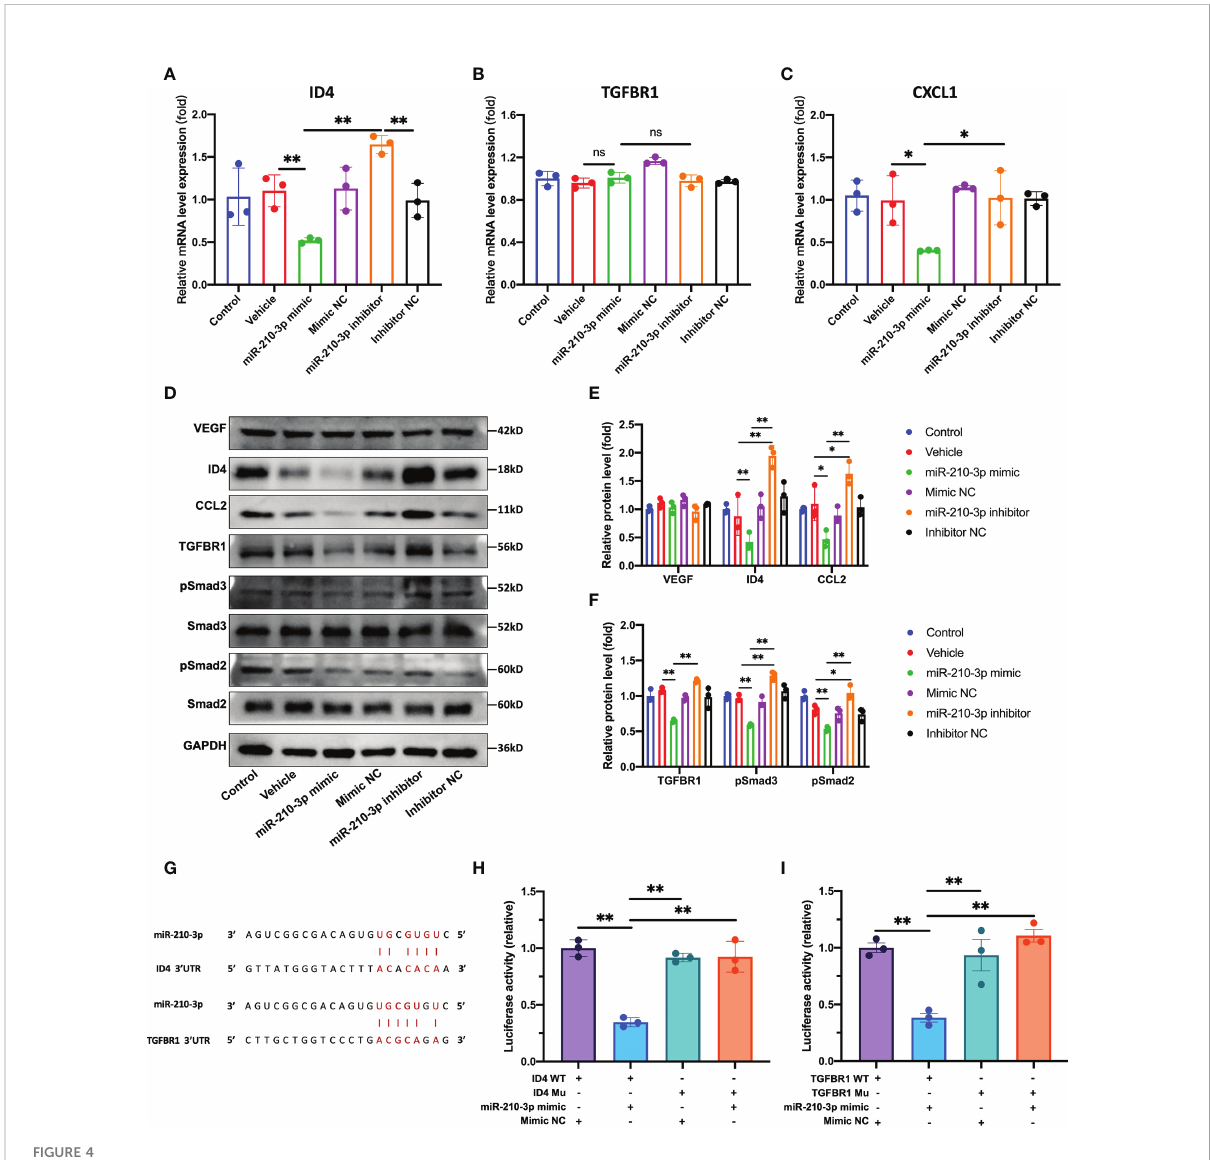
FIGURE 4 miR-210-3p directly targets TGFBR1 and ID4. (A – C) ID4, TGFBR1 and CXCL1 mRNA expression levels quanti fi ed by RT – qPCR. (D – F) Representative bands showing the levels of the VEGF, ID4, CCL2, TGFBR1, Smad2, pSmad2, Smad3, pSmad3 and GAPDH proteins (D) . The relative VEGF, ID4, CCL2 and TGFBR1 protein levels were normalized to the GAPDH level. The relative pSmad2 and pSmad3 protein levels were normalized to those of Smad2 and Smad3, respectively (E, F) . (G) Predicted binding sites for miR-210-3p in the ID4 and TGFBR1 sequences. (H, I) A dual-luciferase reporter assay showed that luciferase activity was signi fi cantly inhibited in groups cotransfected with ID4 or TGFBR1 WT vectors and miR-210-3p mimic. ** P < 0.01. * P < 0.05. WT, wild-type. Mu, mutant. ns, not signi fi cance. All data are presented as the means ± standard deviations. Statistical signi fi cance was determined using unpaired, 2-tailed Student ’ s t